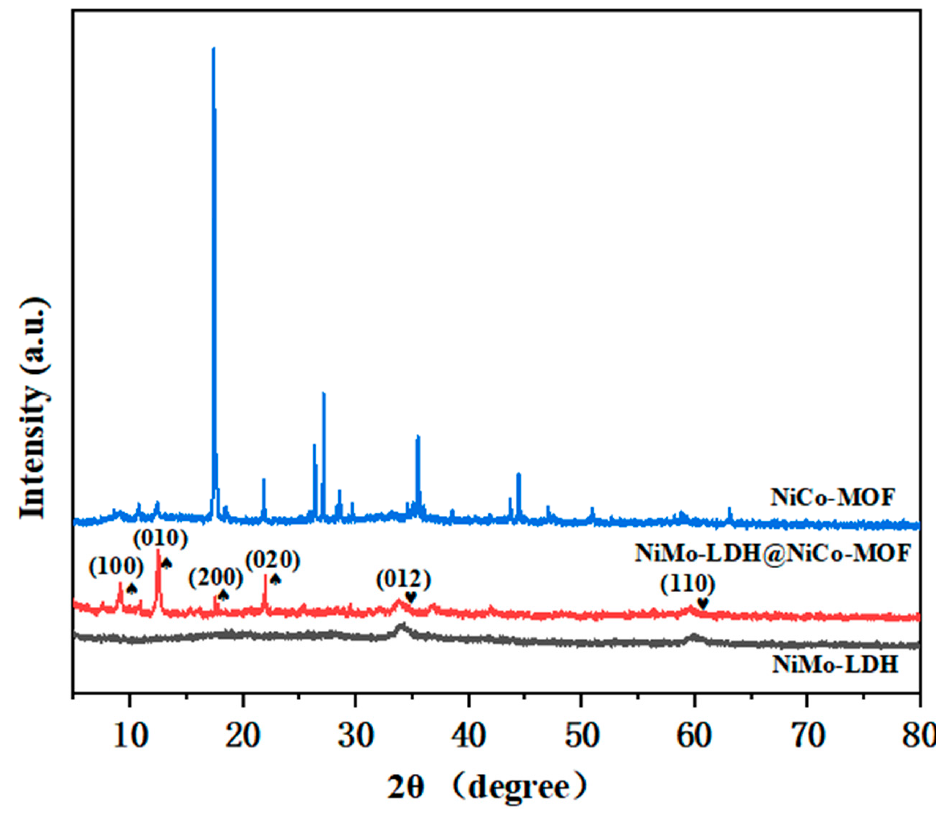
Figure 3. X-ray diffraction patterns of different samples.